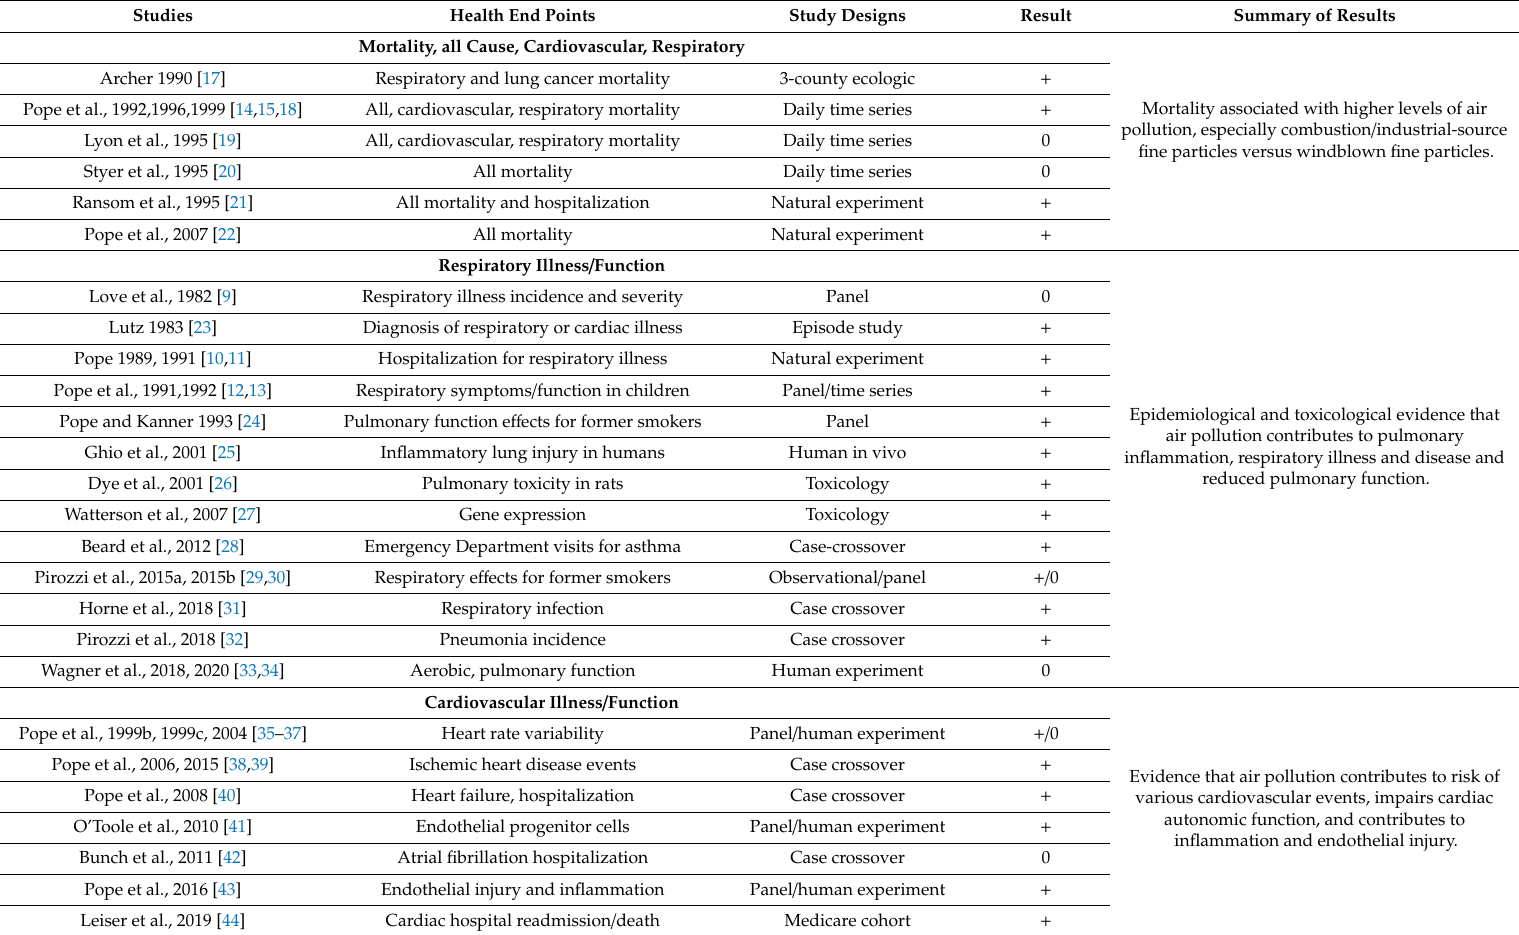
Table 1. Outline and review of air pollution and health studies from